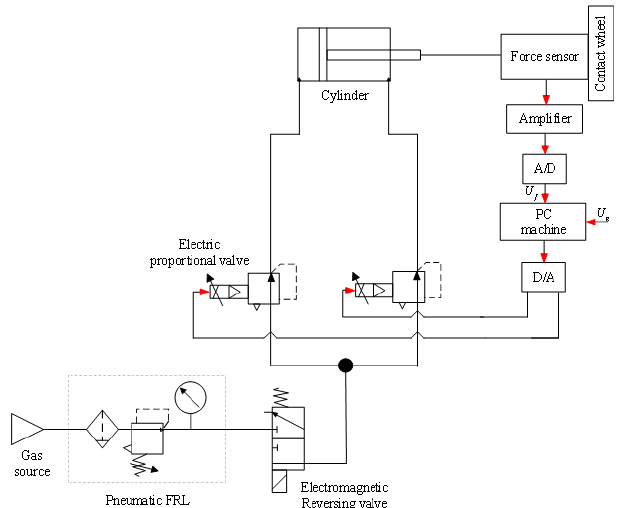
Figure 9. Structure diagram of a fuzzy self-adaptive